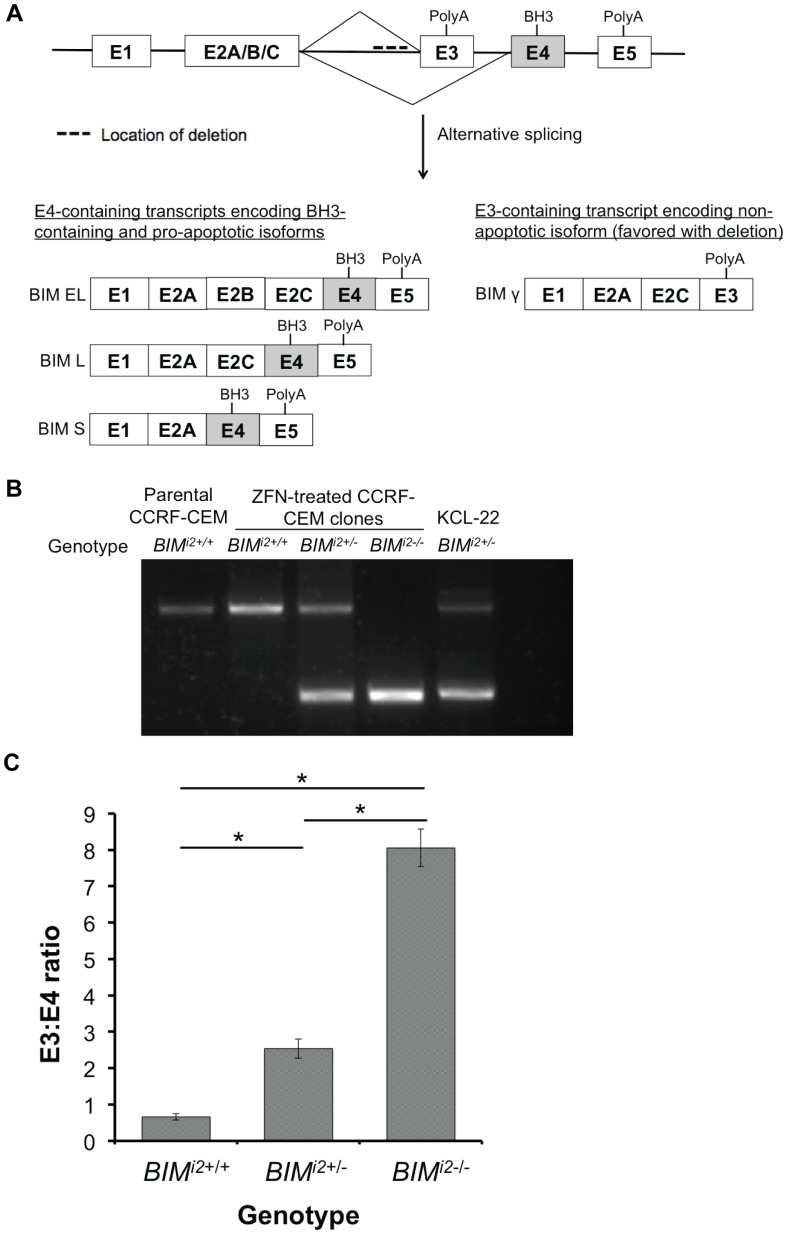
Generation of isogenic CCRF-CEM cell lines with the BIM deletion polymorphism.(A) Structure of the BIM gene and major splice isoforms. The BIM deletion polymorphism lies within intron 2 and upstream of exon 3, as indicated by the dashed line. Exon 4 contains the crucial BH3 domain required for apoptosis. Exon 3 (E3) and 4 (E4) are spliced in a mutually exclusive fashion, leading to the generation of either E4-containing isoforms with the BH3 domain (BIM EL, BIM L and BIM S) or E3-containing isoforms without the BH3 domain (BIM γ). When present, the deletion biases splicing towards E3-containing non-apoptotic isoforms. (B) Agarose gel of the products from a PCR reaction to detect the polymorphism in zinc finger nuclease (ZFN)-treated CCRF-CEM subclones, with the lower band indicating the presence of the deletion. Parental CCRF-CEM and KCL-22 cells (a CML cell line known to be heterozygous for the BIM deletion polymorphism) were included as controls. (C) The ratio of exon 3 to exon 4-containing transcripts (E3:E4) in CCRF-CEM BIMi2+/+, BIMi2+/− and BIMi2−/− clones as measured by qPCR. Error bars indicate mean ± SEM (n = 3). A student's t-test was performed for pairwise comparisons of E3:E4 ratio between genotypes. * indicates a significant difference with P<0.05.